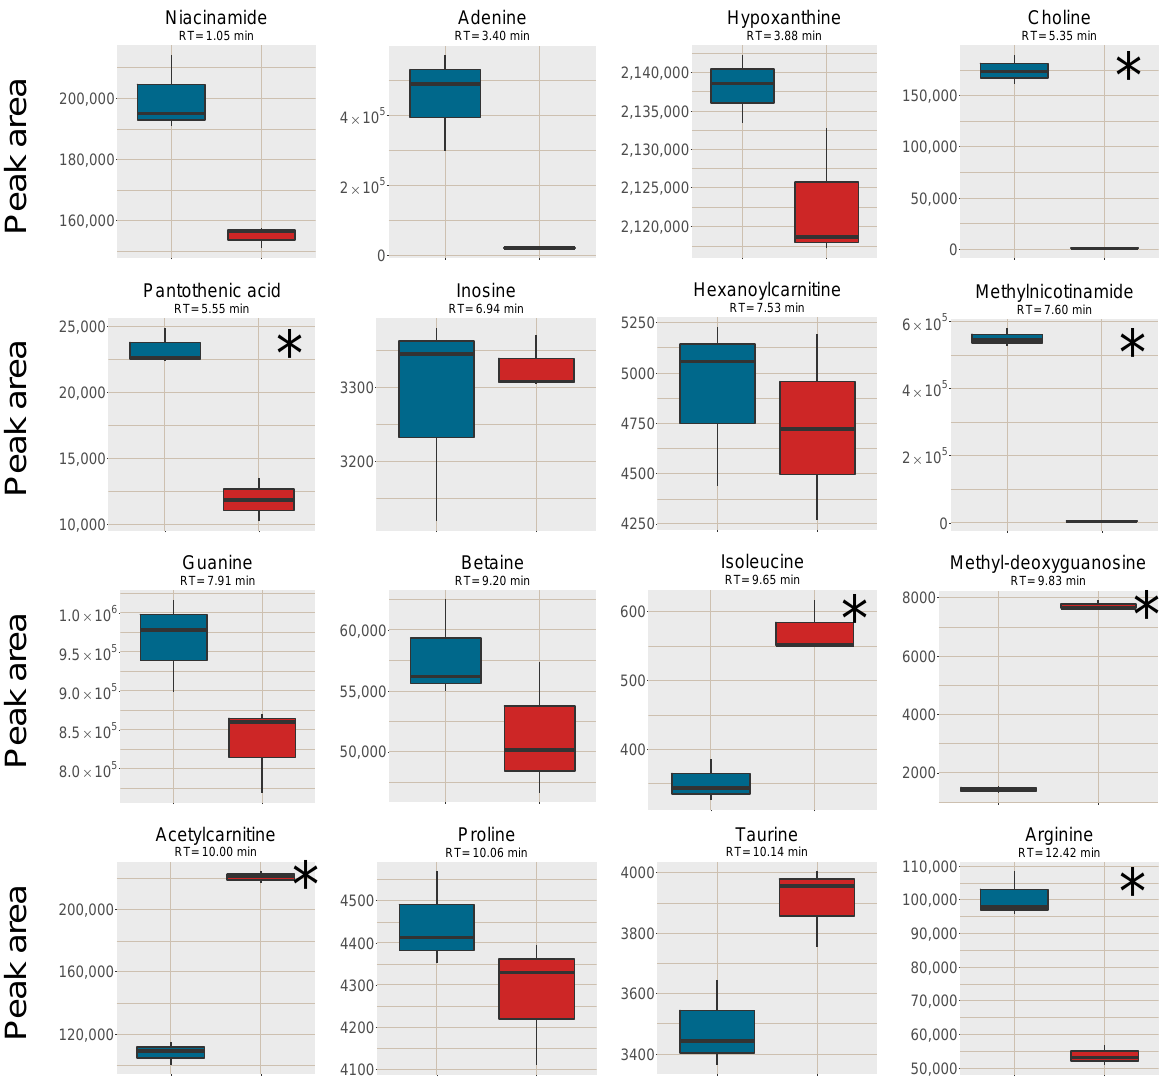
Figure 7. Box plots of the peak area of [M+H] + (or [M] + where applicable) of all investigated analytes in the cell samples, red box = SPE MCX, blue box = LLE. The outer edges of the boxes represent the first and third quartiles respectively while the middle line represent the median and outliers are denoted by dots in the plots. Analytes with statistically different peak area ( p < 0.05 in a unpaired t -test with bonferroni correction applied) between the two sample treatments are marked with a * in the top right corner of each individual box-plot.